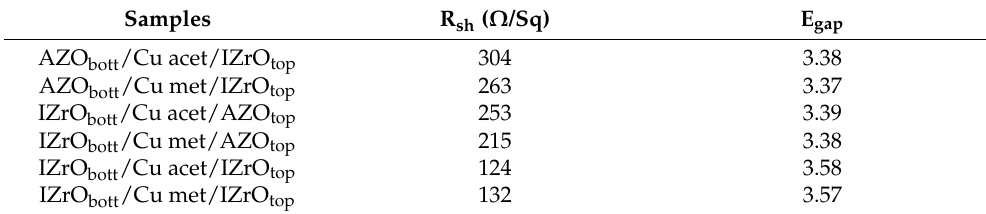
Table 2. Wet systems with all combination of AZO and IZrO layers as the top and bottom TCO.